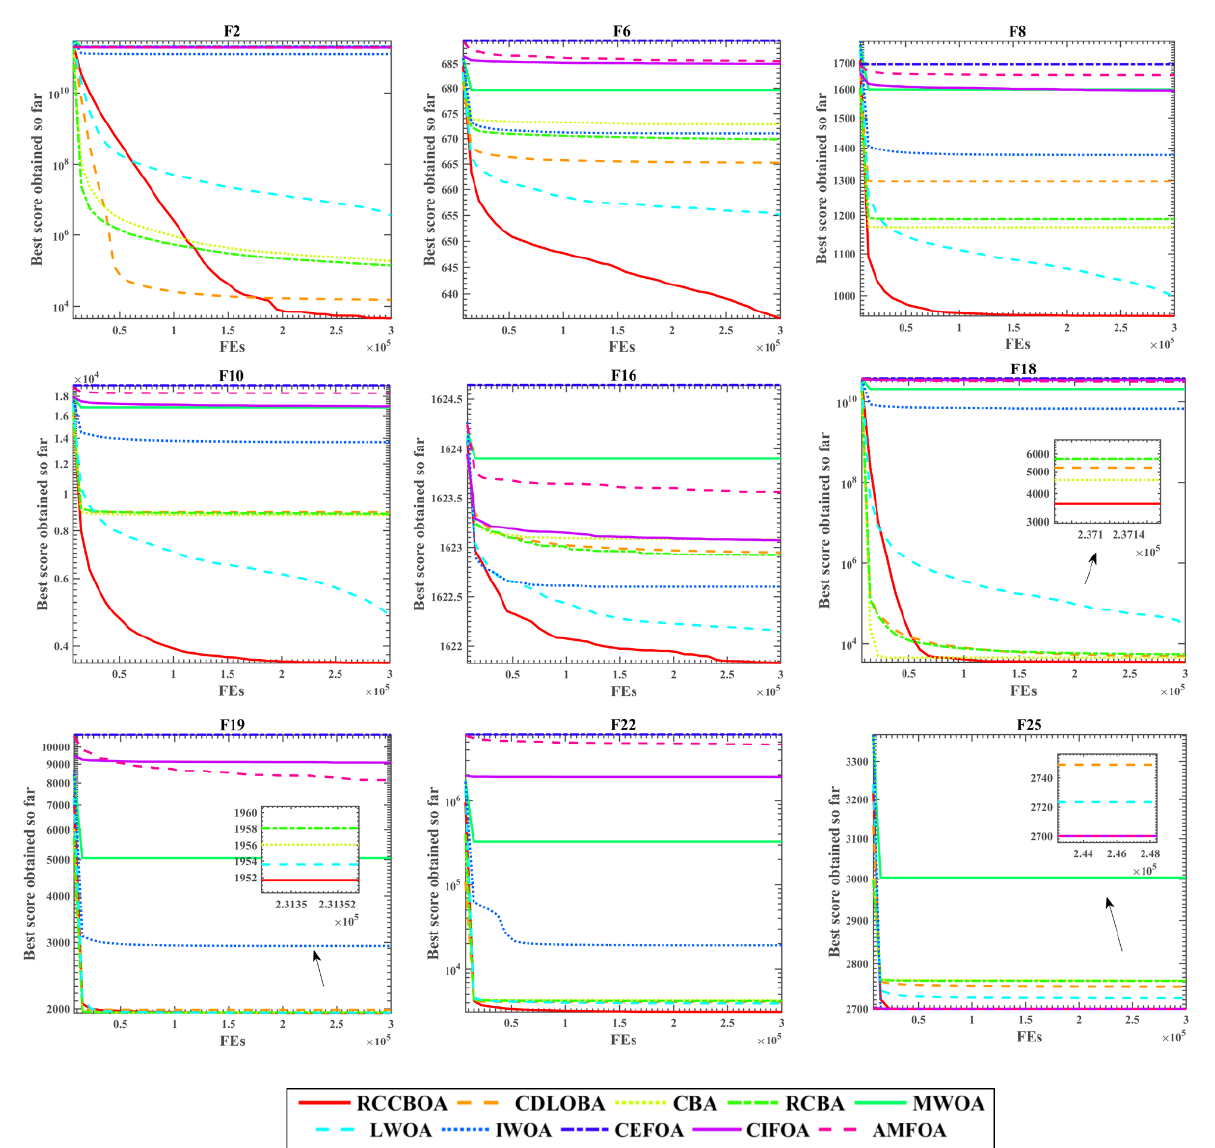
Figure 4. Convergence tendency of the RCCBOA and other advanced algorithms.